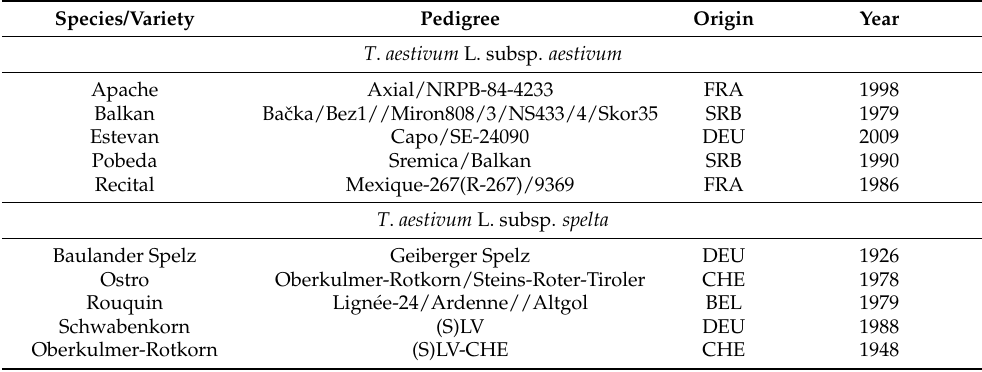
Table 1. The country of origin, the year of release and the pedigree of bread and spelt wheat varieties analyzed in this research according to the Genetic Resources Information System for Wheat and Triticale (GRIS) database.